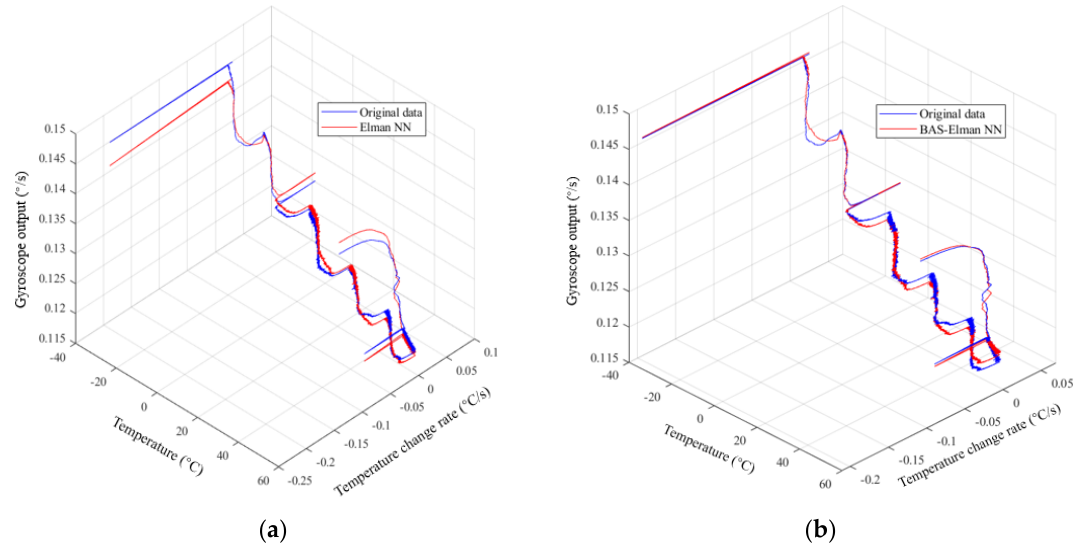
Figure 16. ( a ) Comparison of predicted output and actual output of Elman NN before optimization; ( b ) Comparison of the optimized predicted output and actual output of Elman NN.